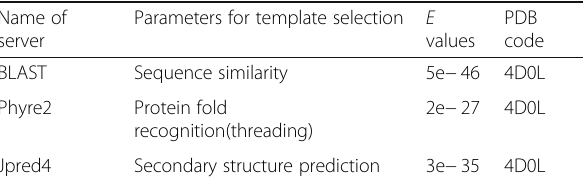
Table 1 Template search results for Rab39a Name of server